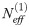
EWS for γ = 9.An increase in standard deviation as well as autocorrelation can be observed prior to the critical transition, both for the natural state N(1) (blue) and the effective state Neff(1) (green) in networks with γ = 9.